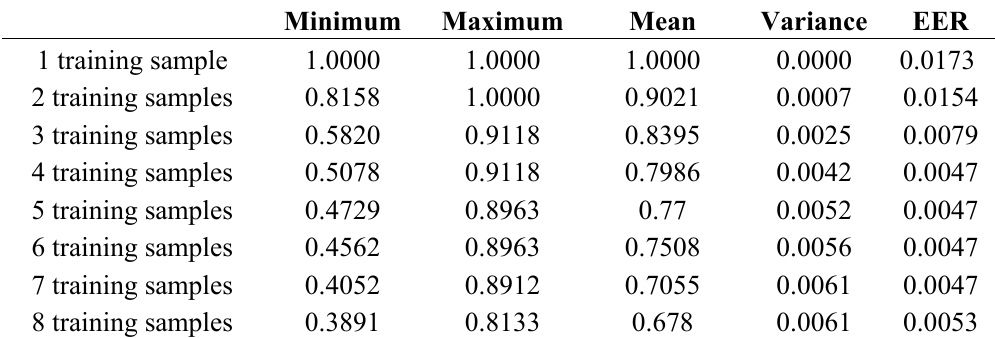
Table 8. Statistical data of the percentage by different number of training samples.